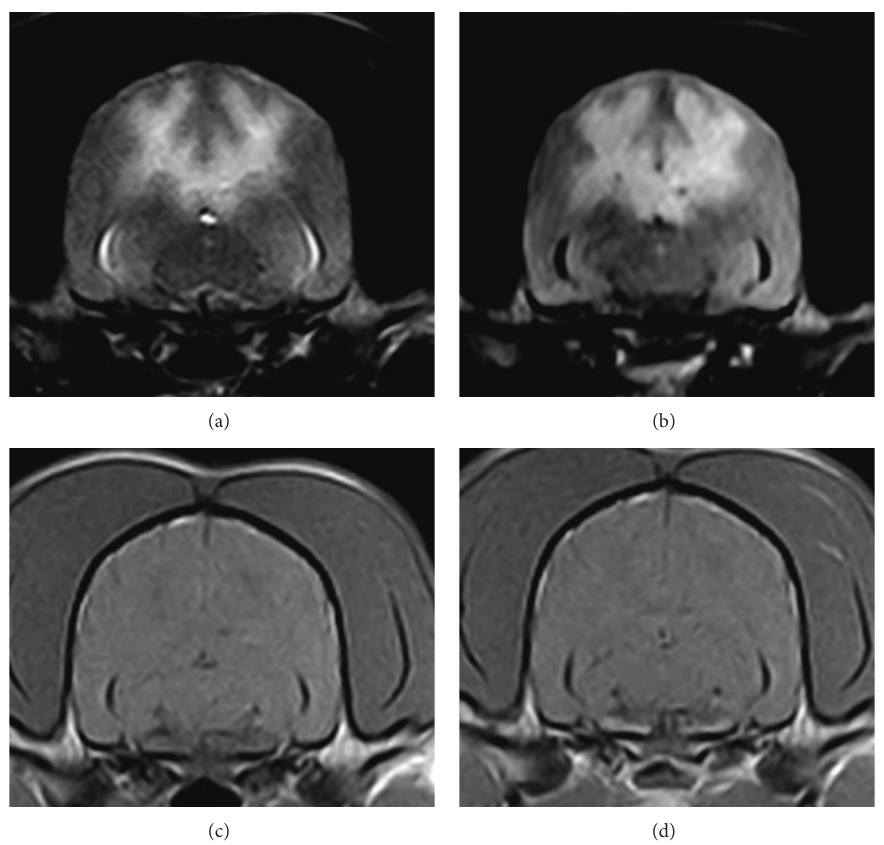
Figure 1: (a) T2-weighted (TR = 3720 ms, TE = 90 ms, slice thickness = 3,5 mm), (b) FLAIR (TR = 4000ms, TE = 100 ms, TI = 1000 slice thickness = 3,5 mm), and (c) T1-weighted (TR = 600 ms, TE = 18ms, slice thickness = 3,5 mm) pre- and (d) postcontrast transverse images at the level of the caudal mesencephalic aqueduct. There is bilateral and symmetric T2 and FLAIR hyperintensity within the parieto-occipital periventricular and subcortical white matter. The lesions are isointense on T1-weighted images and did not enhance after contrast medium administration. No mass effect is present.